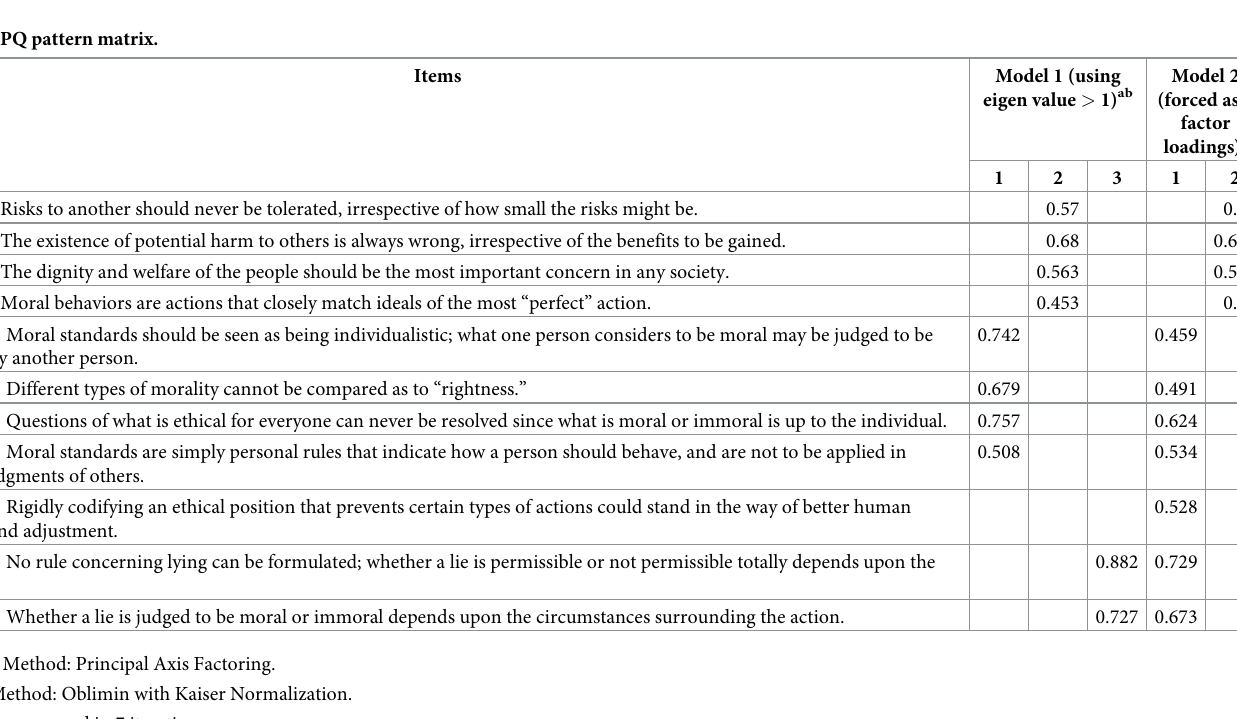
Table 3. EPQ pattern matrix.